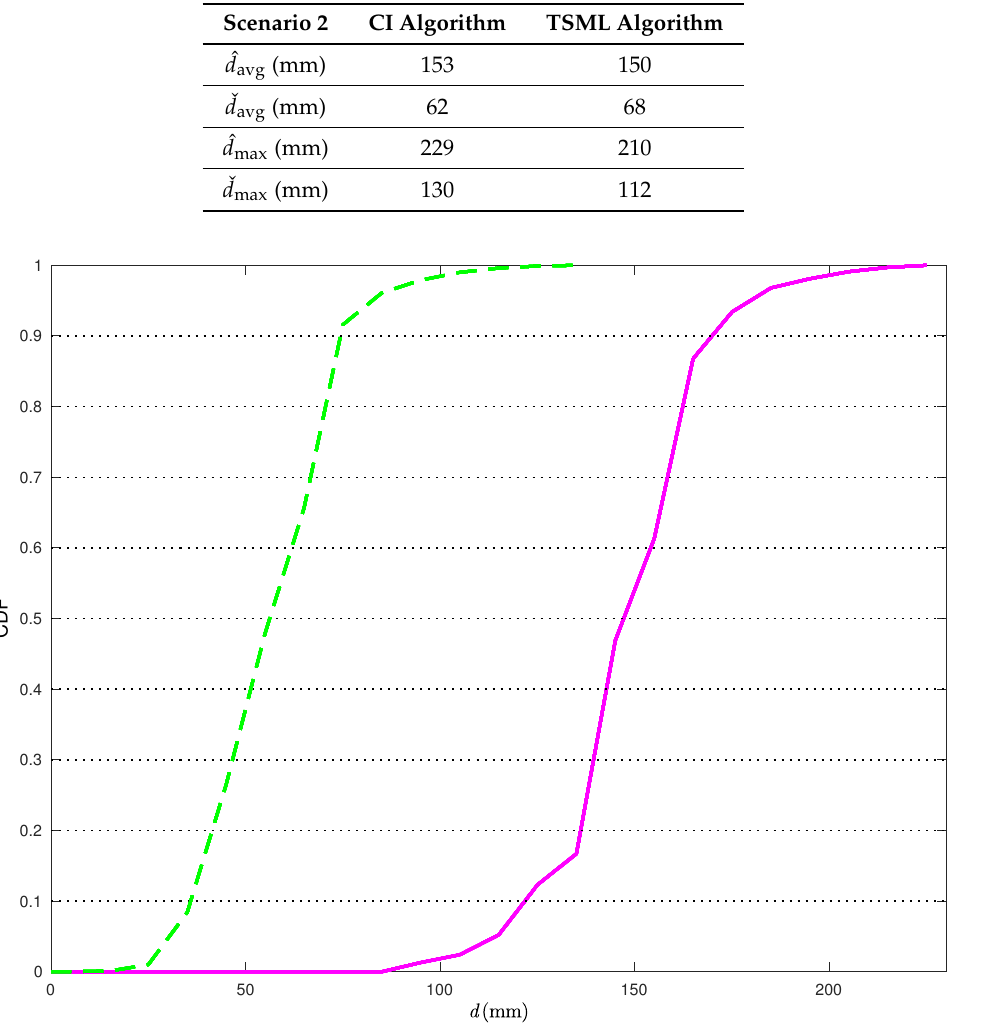
Figure 11. CDFs of the distance errors obtained with the CI localization algorithm in Figure 10 without (solid line) and with (dashed line) the statistical